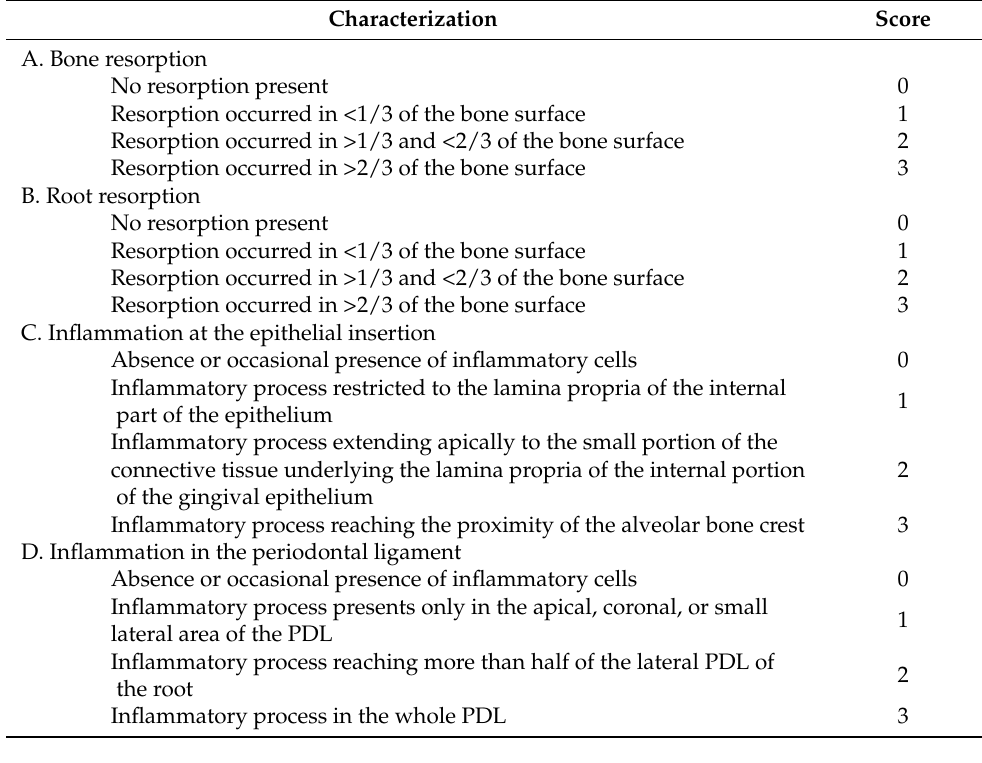
Table 3. Scores for quantitative analysis in histological